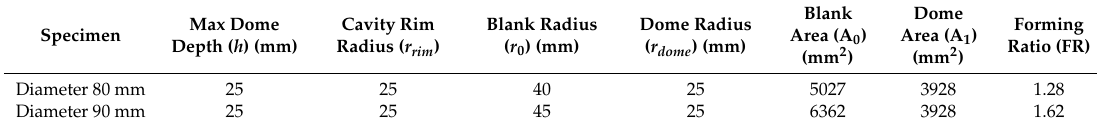
Table 3. Forming ratio (FR) calculated for samples in Figure 11 using Equation